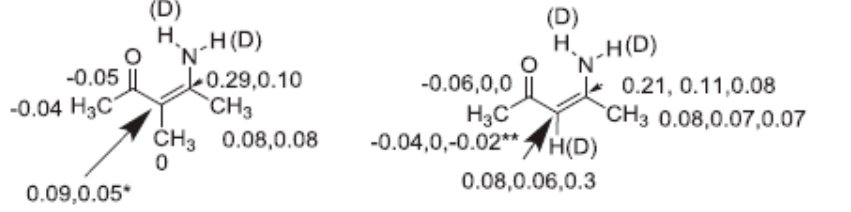
Figure 11. Two-bond deuterium isotope effects on 13 C chemical shifts of 1,4-dihydropyridines. ( A ) Without intra-molecualr hydrogen bond; ( B ) with intramolecular hydrogen bond From Ref. [30]. 3.4. Dimers and Trimers Tolstoy et al. in a very elegant way have used isotope effects on chemical shifts to determine the size of self-associated dimethylphosphinic, diphenylphosphoric acid, phe- nylphosphinic acid and bis(2,4,4-trimethylpentyl)phosphinic acid [31]. This has been ex- tended to investigate heterodimers and heterotrimers of phosphinic and phosphoric acids (see Figure 12) [32]. Using the same technique, it could be proven that dimethylarsenic acid forms cyclic dimers in solution with two equivalent strong hydrogen bonds [33].